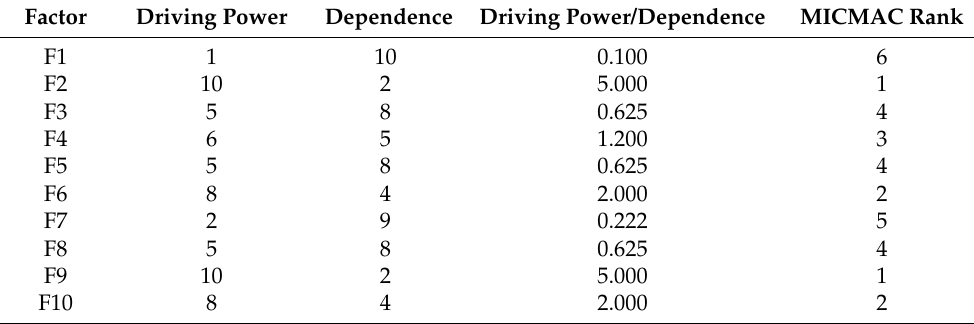
Table 6. MICMAC rank for factors influencing green operations strategies in